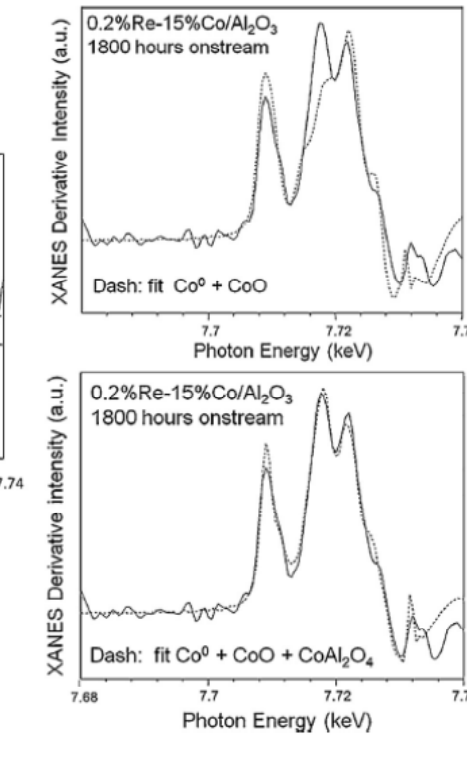
Figure 7. From the run shown in Figure 5, XANES derivative spectra of (left ) freshly reduced/passivated catalysts, which could be fit with Co 0 and CoO, and (right) used catalyst samples, which could only be fitted with Co 0 , CoO, and CoAl from [44] (Copyright 2003, Elsevier) and [45]